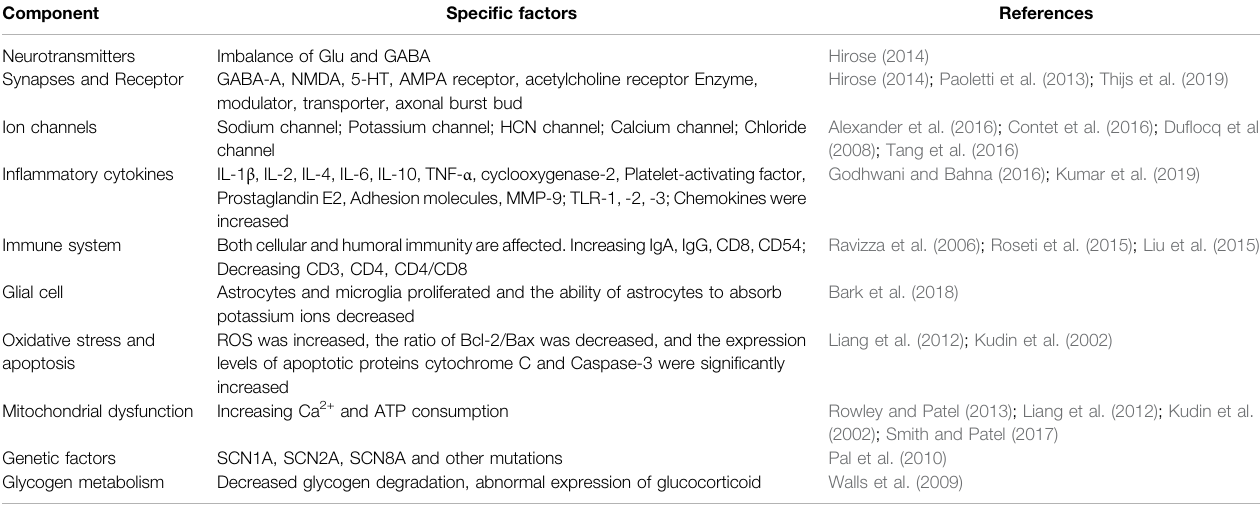
TABLE 1 | Possible mechanisms involved in